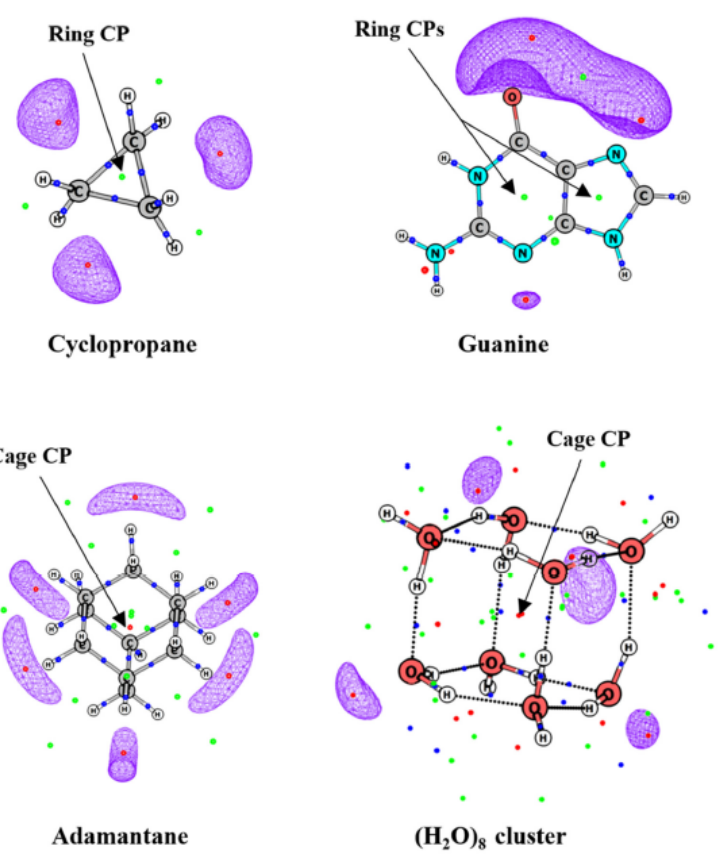
Figure 3. MESP topology of some molecules obtained from B3LYP/6-311G (d, p) calculations. Blue, green and red dots correspond to (3, − 1), (3, +1) and (3, +3) critical points (CPs). Isosurface values are − 10, − 40, − 2, and − 10 kcal/mol for cyclopropane, guanine, adamantine and (H 2 O) 8 cluster, respectively.